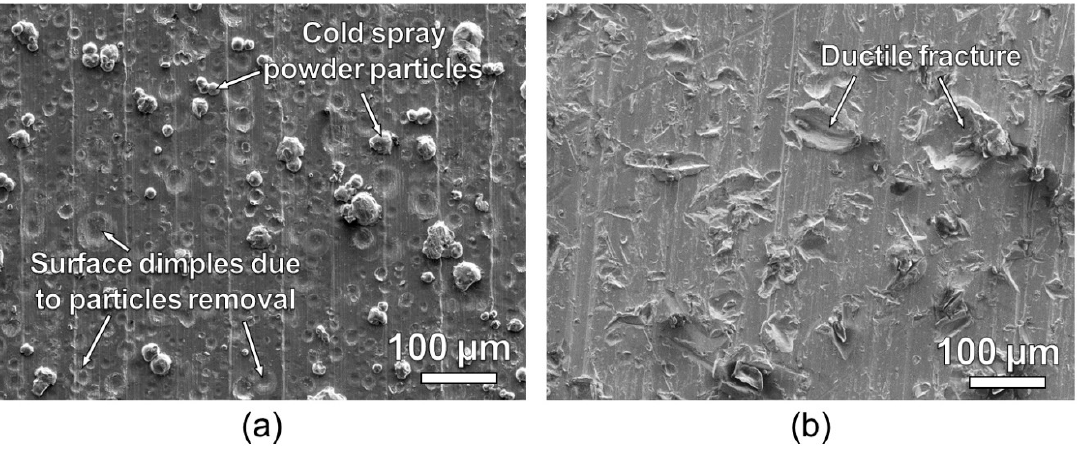
Figure 13. Fracture surface (substrate side) after the adhesive bond test for ( a ) as ‐ sprayed and ( b ) post ‐ peened conditions.